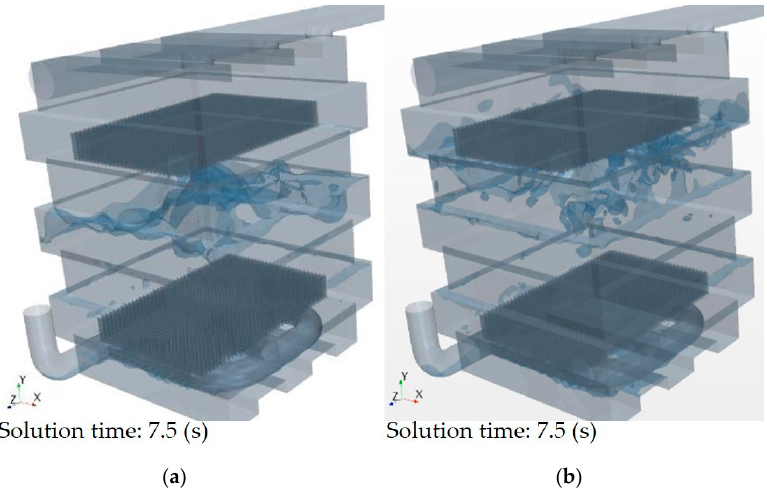
Figure 13. Three-dimensional (3D) validation of the design obtained. Stabilized bubbling of the operation point: ( a ) 0.2 kg/s; ( b ) 0.42 kg/s.